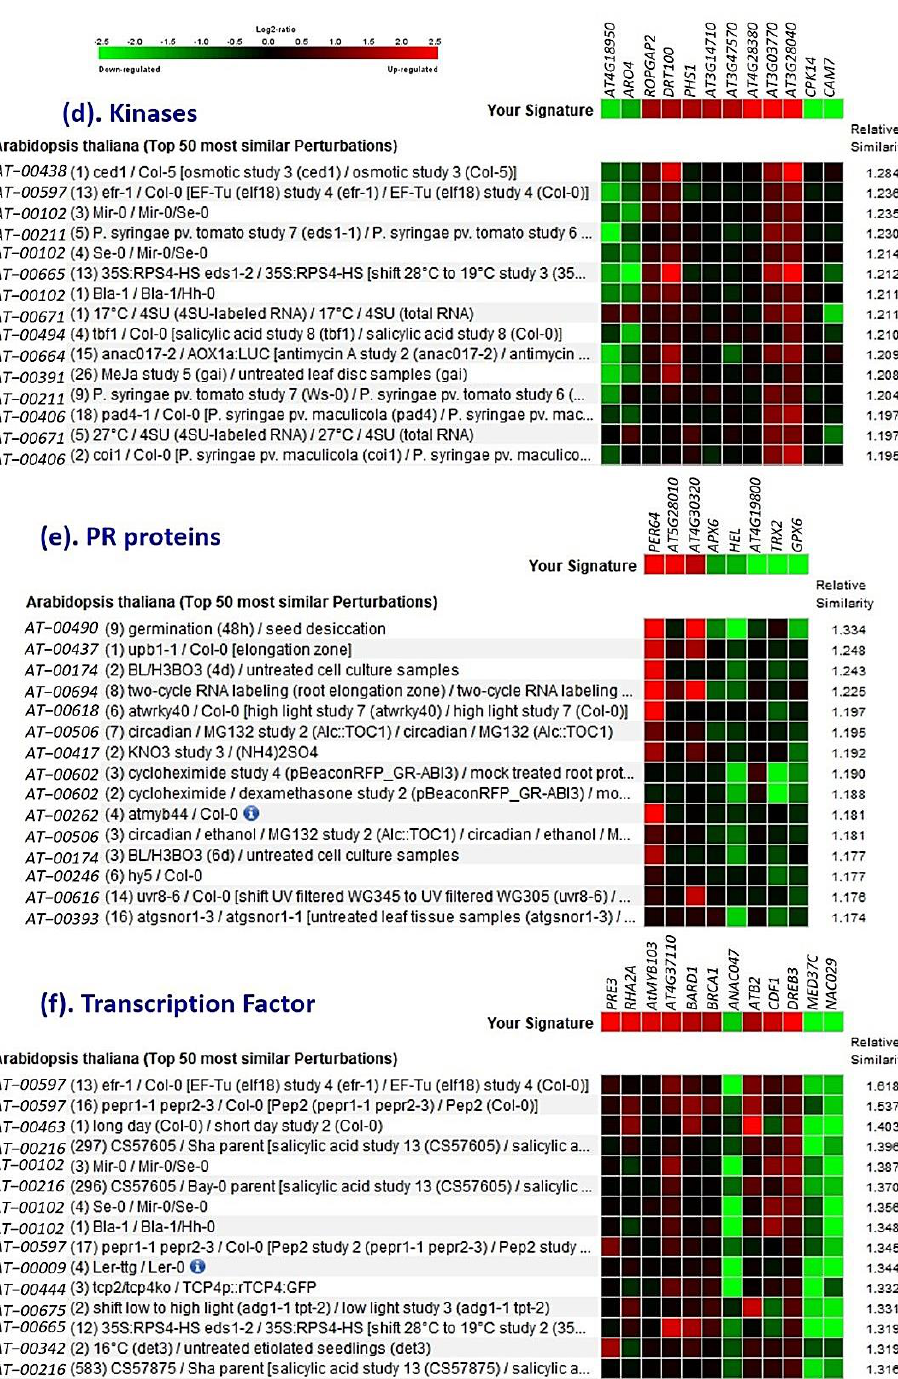
Figure 7. Heat-map that was generated using the DEGs that were associated with ( a ) defense-related enzymes, ( b ) disease responsive genes, ( c ) hormones, ( d ) kinases, ( e ) PR proteins, and ( f ) Transcription factors during lentil- Rhizoctonia interaction. Genevestigator was used and the top 15 perturbations are presented.